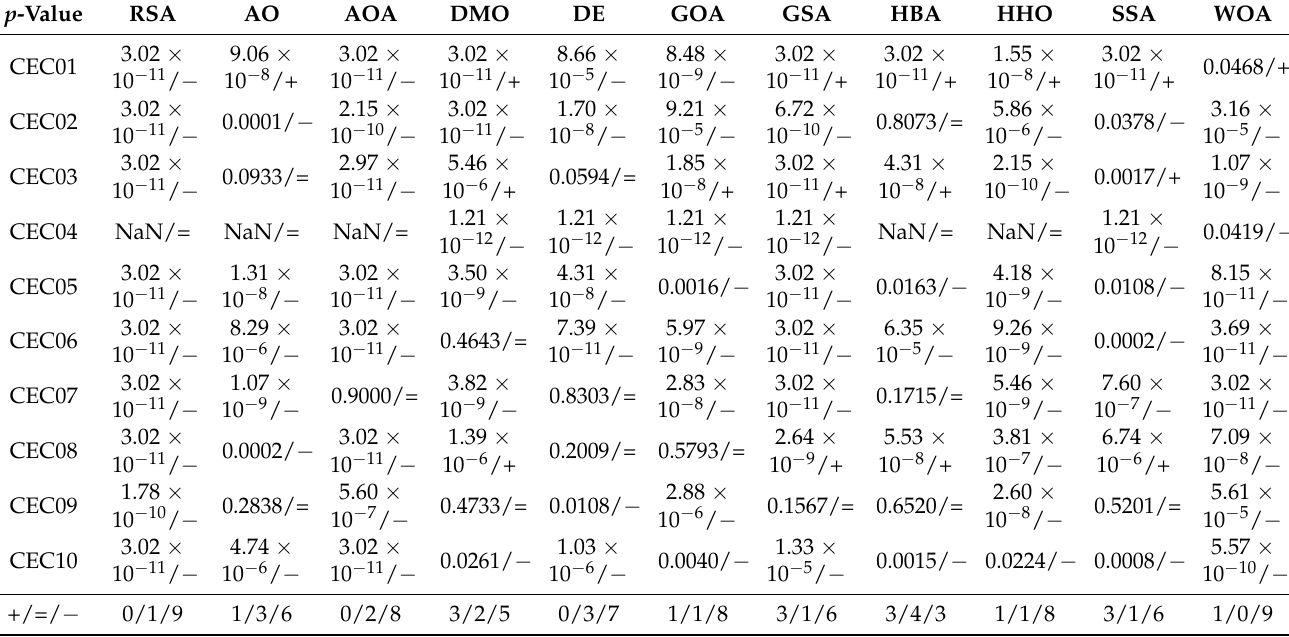
Table 5. p -value and statistical results on CEC2020.